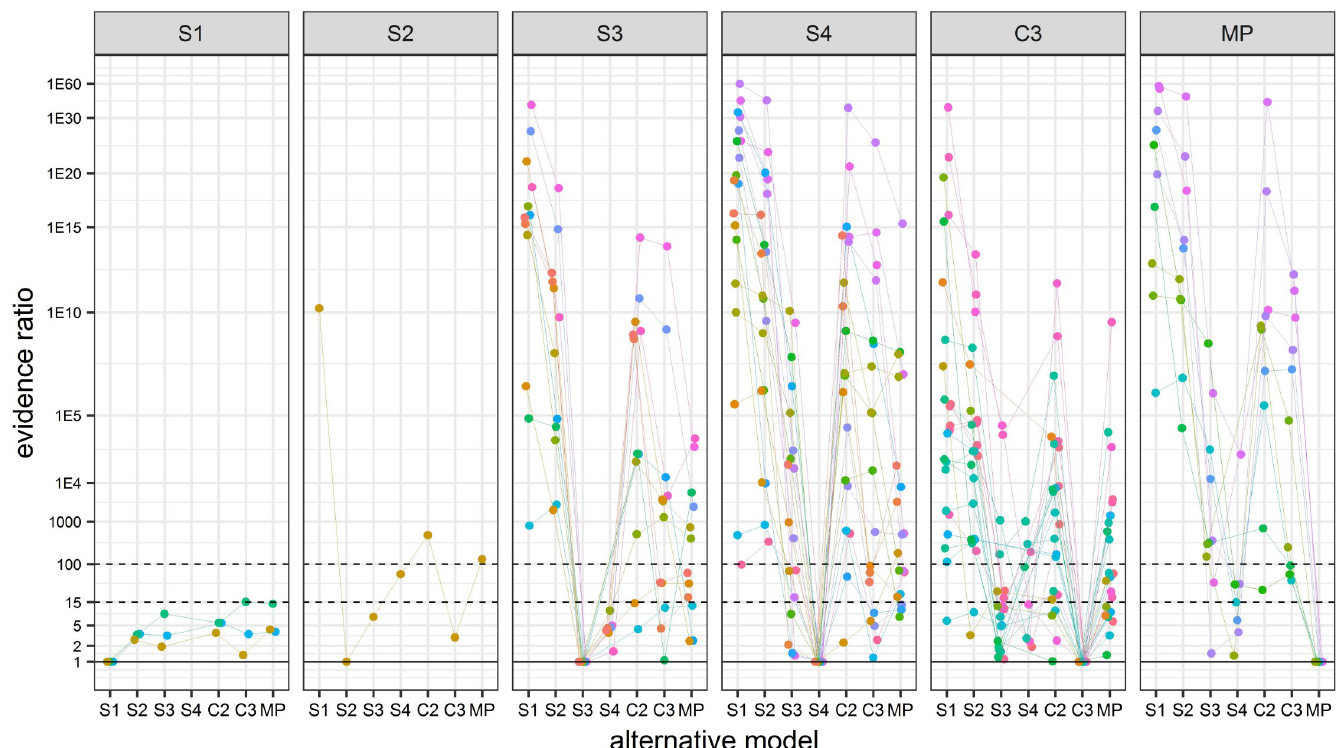
Fig 6. Plot of evidence ratio (ER) vs alternatives to the best model for each of the 68 animals. The ER value for the best model is 1 and values greater than 1 are the fold increase in likelihood in favor of the best model over the alternative model. Each panel gives the plot for all animals with the best model given at the top of the panel. Values from a single animal have the same color and are connected with lines.